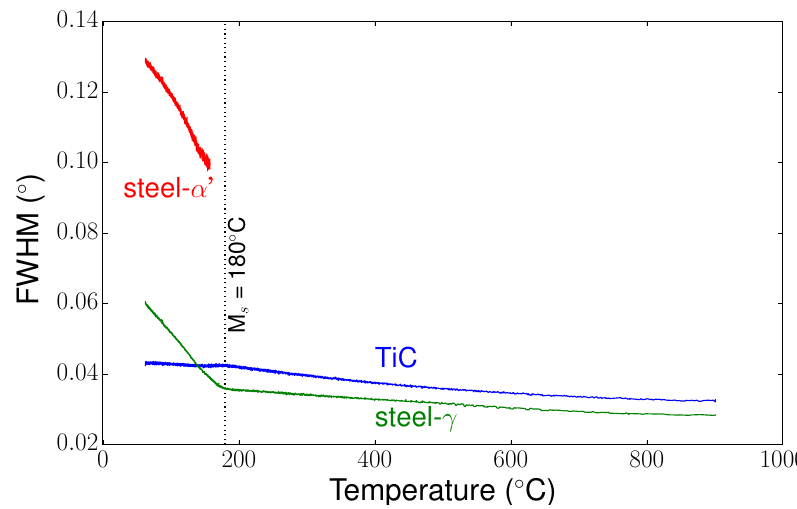
Figure 9. Evolution during cooling of the full width at half maximum (FWHM) for the different phases (steel- γ phase (200), TiC (220), and steel- α (cid:48) phase (211)) versus temperature.